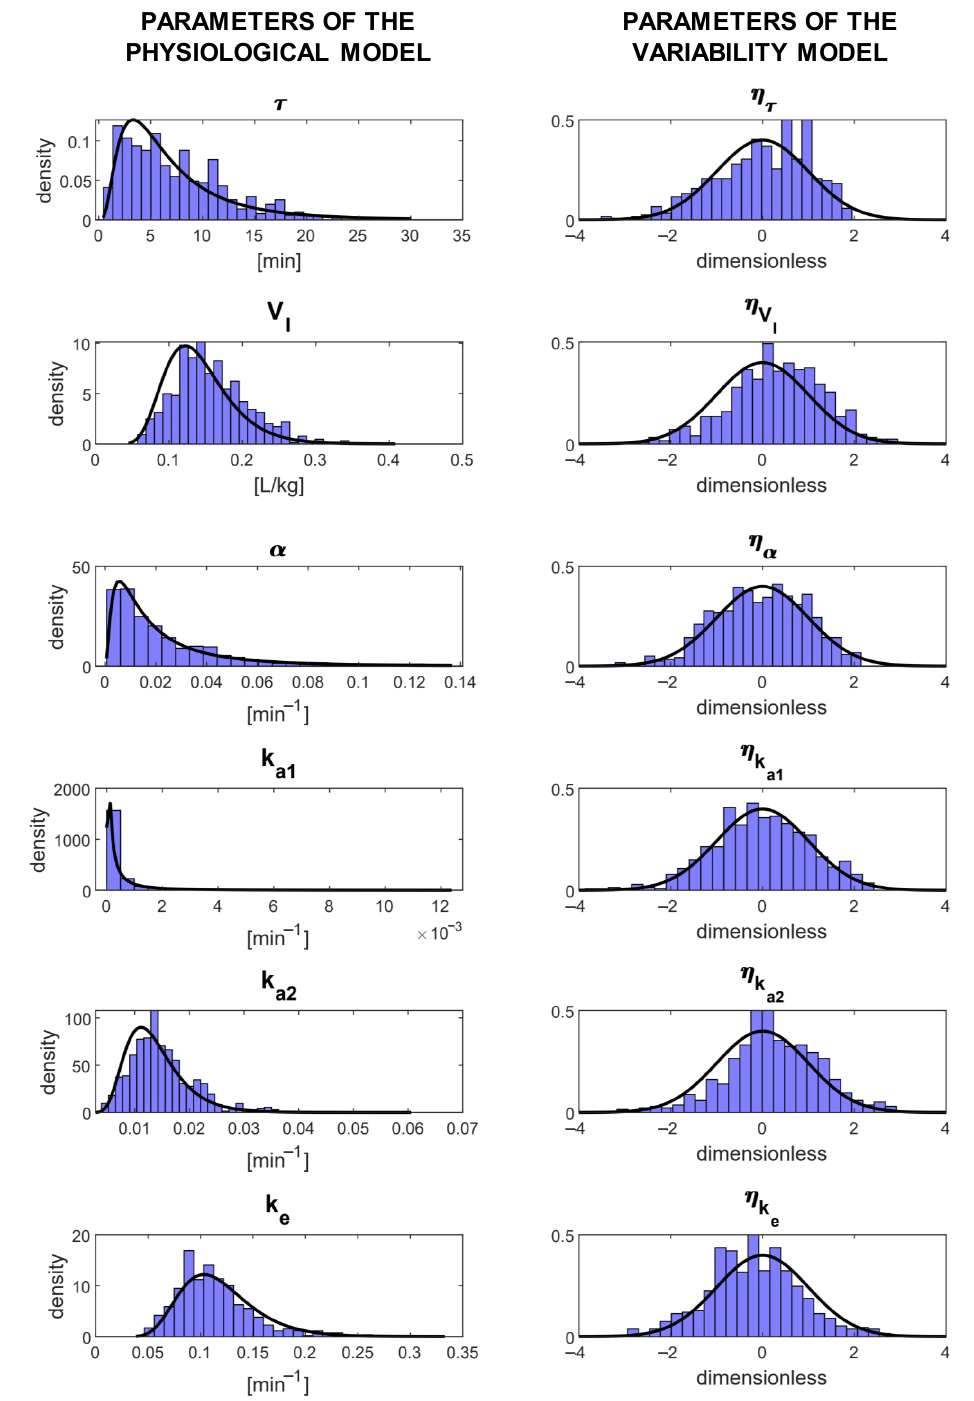
Figure 5. Parameter distributions of Model 11. Left panels: individual parameter distributions compared with the corresponding theoretical distributions (black line). Right panels: random effect distributions compared with a standard Gaussian (black